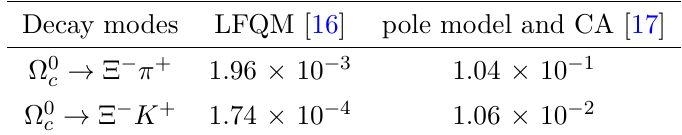
Table 1 . Predicted ratios of branching fractions for Ω 0 c → Ξ − π + and Ω 0 c → Ξ − K + using LFQM [16], pole model [17], and CA [17]. The branching fraction of reference mode Ω 0 to ref.